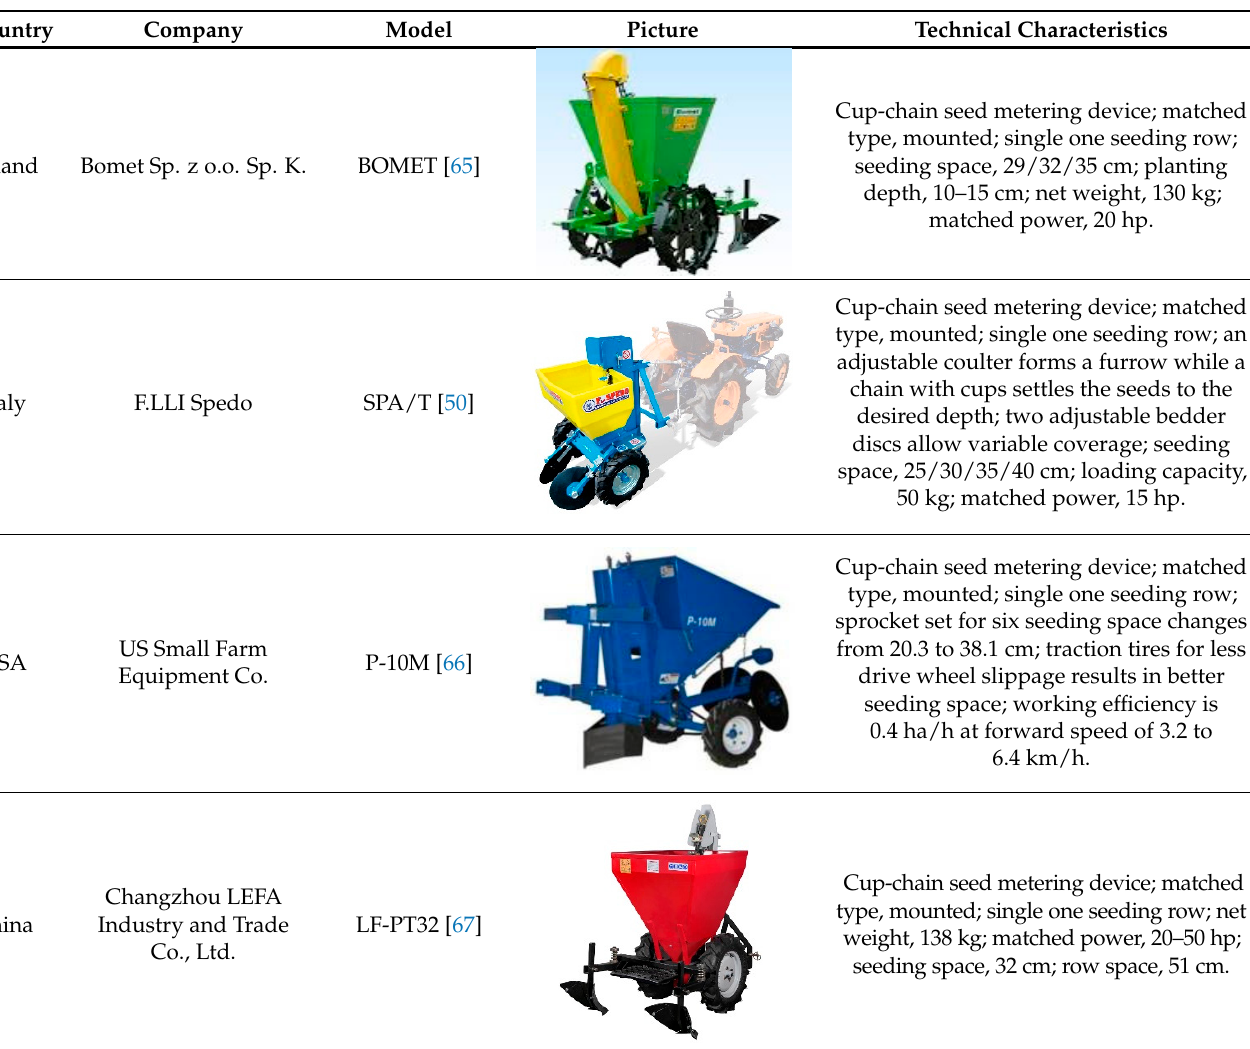
Table 3. Comparison of the cup type potato planter in small scale.